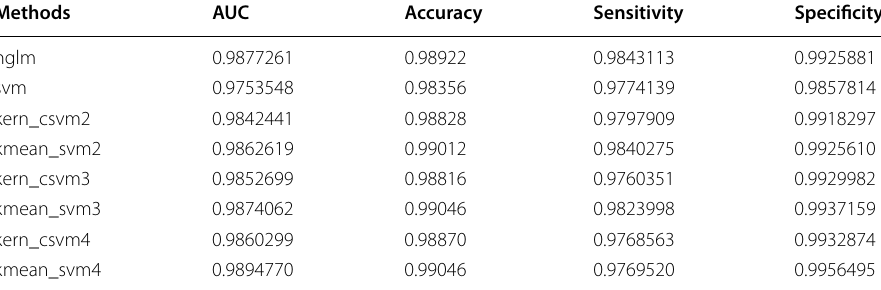
Table 9 Models accuracy